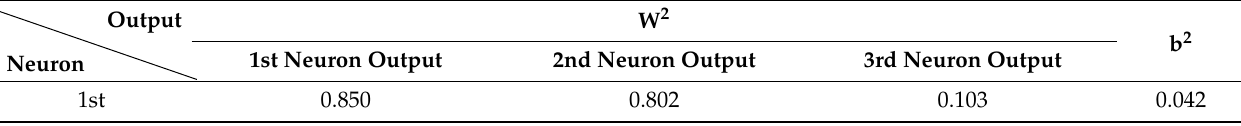
Table A2. Weight(W 2 ) and bias(b 2 ) matrix of output layer (Case: QV L S L S U and Subset 5). The superscript 2 indicates the output